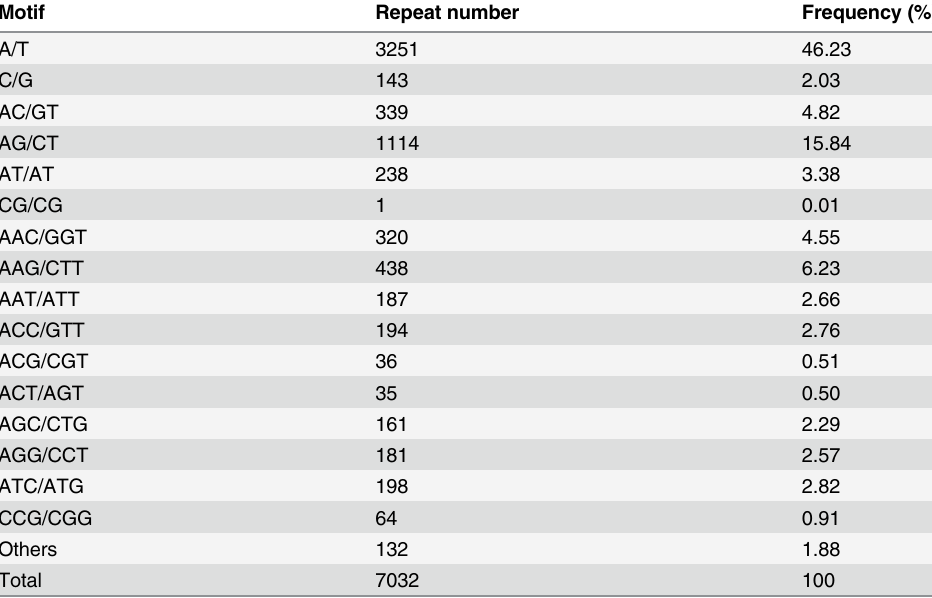
Table 4. Amounts of different SSR repeat motifs in licorice.